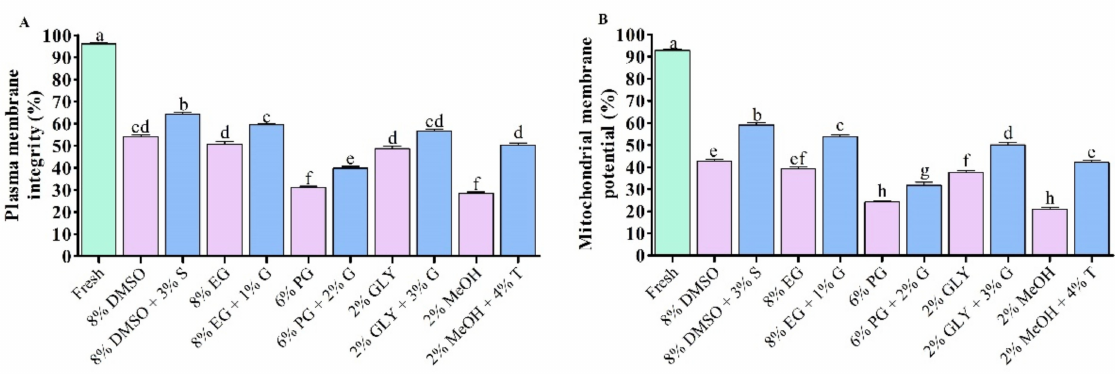
Figure 2. Post-thaw sperm quality of saccharide supplemented cryopreserved sperm of Pacific abalone. ( A ) Plasma membrane integrity (PMI) and ( B ) Mitochondrial membrane potential (MMP) of saccharide supplemented cryopreserved sperm. DMSO: dimethyl sulfoxide, EG: ethylene glycol, PG: propylene glycol, GLY: glycerol, MeOH: methanol, S: sucrose, G: glucose, T: trehalose. Significantly different levels ( p < 0.05) are denoted by different letters.